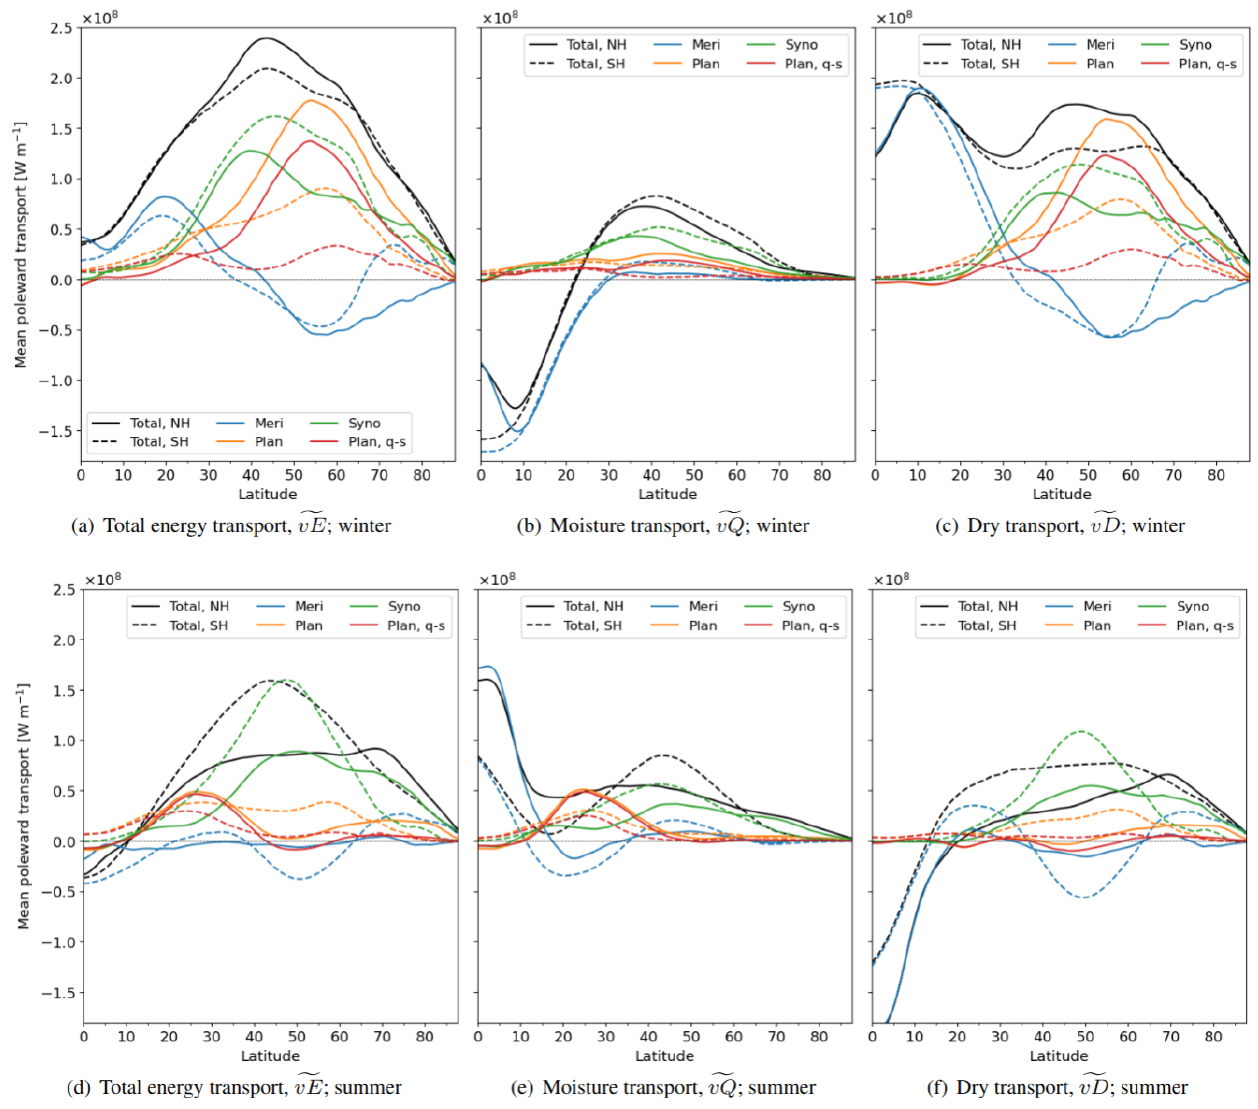
Figure 6. As Fig. 5a–c but for the seasonal-mean transport of (a–c) winter and (d–f) summer for (a, d) the total energy transport, (b, e) its latent component, and (c, f) its dry